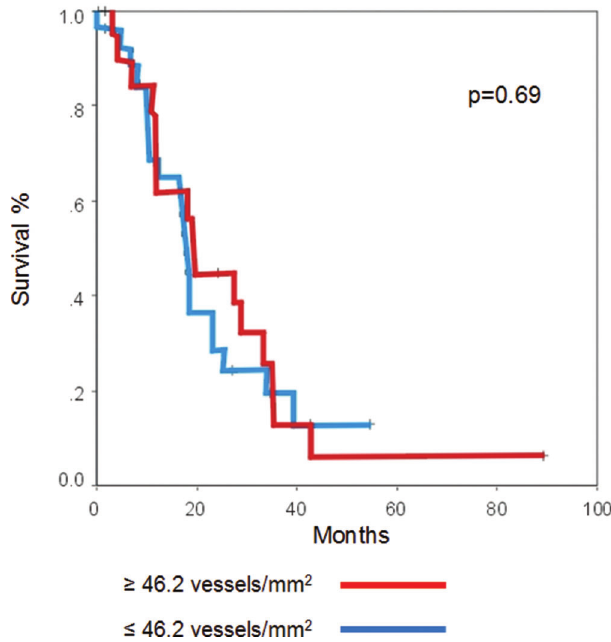
Figure 2 - Relationship between overall survival (months) and microvessel